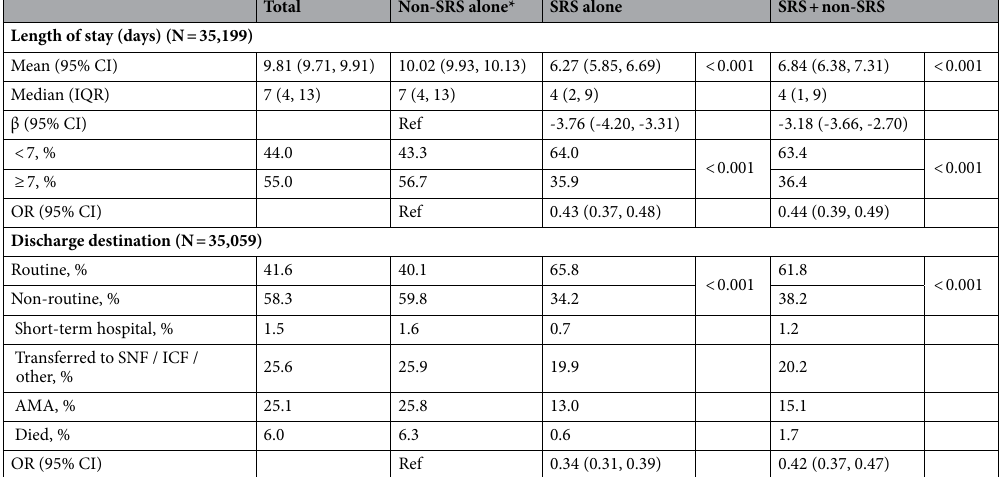
SRS alone vs. non-SRS alone SRS + non-SRS vs. non-SRS